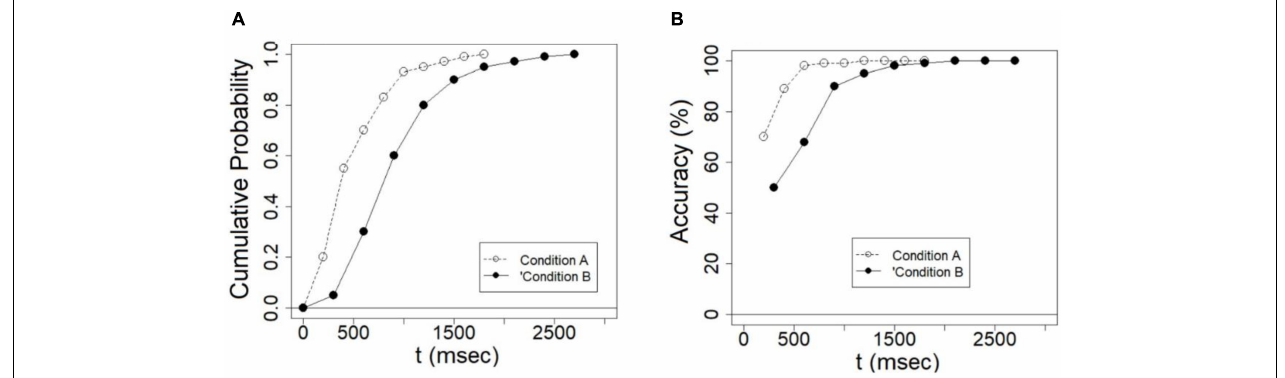
FIGURE 3 | (A) Examples of cumulative probability functions for a fast condition A and a slow condition B. The former reaches its asymptote earlier than the latter. The difference between the functions at a given time indicates the size of the effect at that time. (B) Examples of conditional accuracy functions (CAFs) for fast and slow conditions. Differences in accuracy at a given time indicate the size of the effect in terms of accuracy at that time.